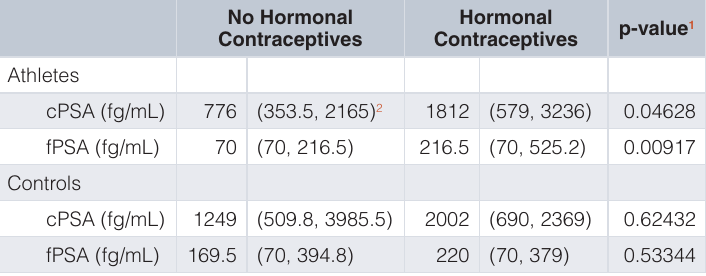
We also examined whether cPSA and fPSA correlated with pro- gesterone. We found no correlation, in either the control or athlete groups, as stratified by hormonal contraceptive use (Supplementary Figure 4). We further dichotomously classified progesterone as being ≥ 5.3 ng/mL (indicative of luteal phase) or < 5.3 ng/mL in athletes and controls not using oral contraceptives, and examined any association with cPSA or fPSA. We found no association (Supplementary Figure 5).